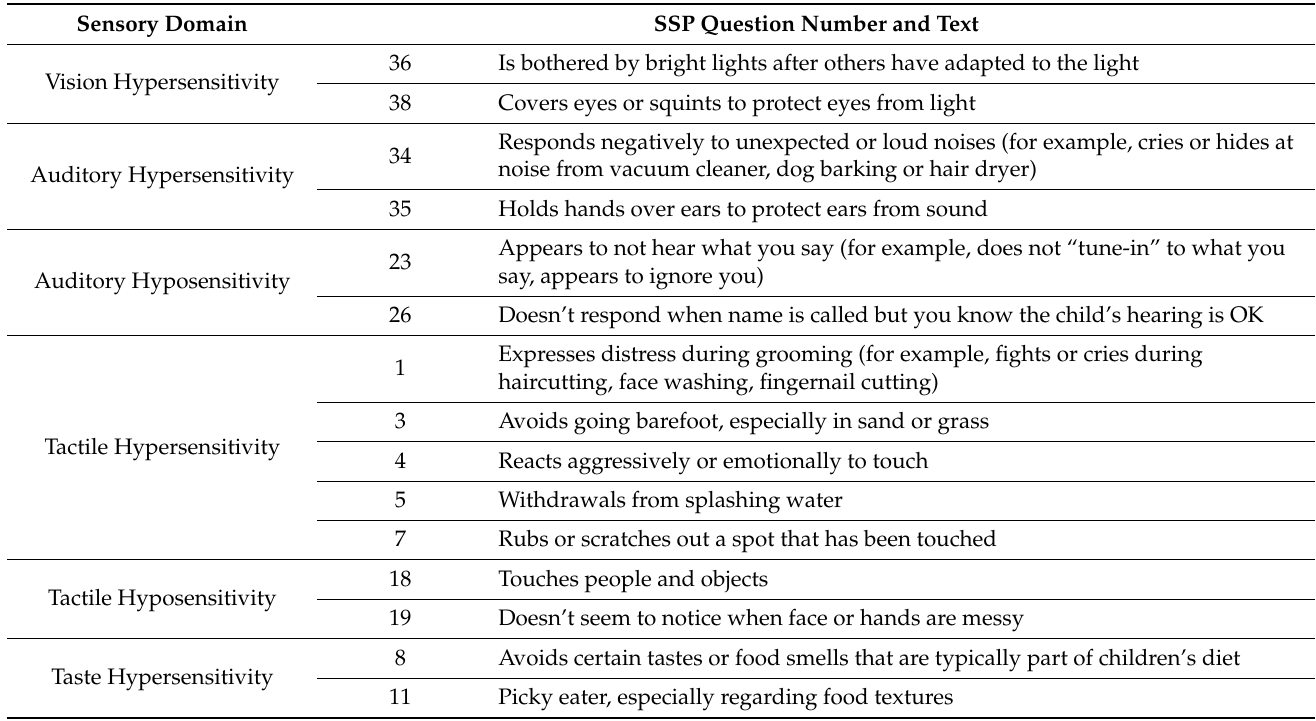
Table 2. Subset of questions from the SSP used to evaluate hyper- and hypo-